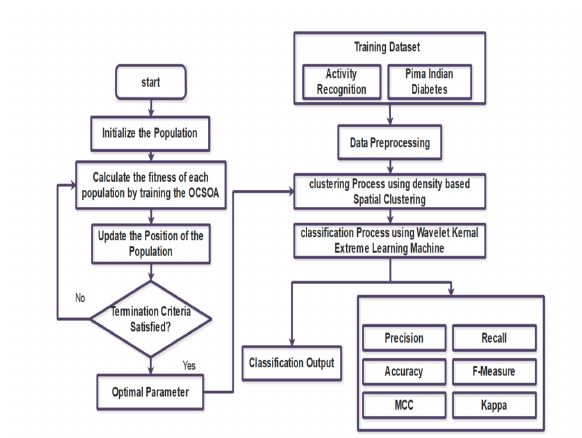
Fig. 1. Proposed art image segmentation